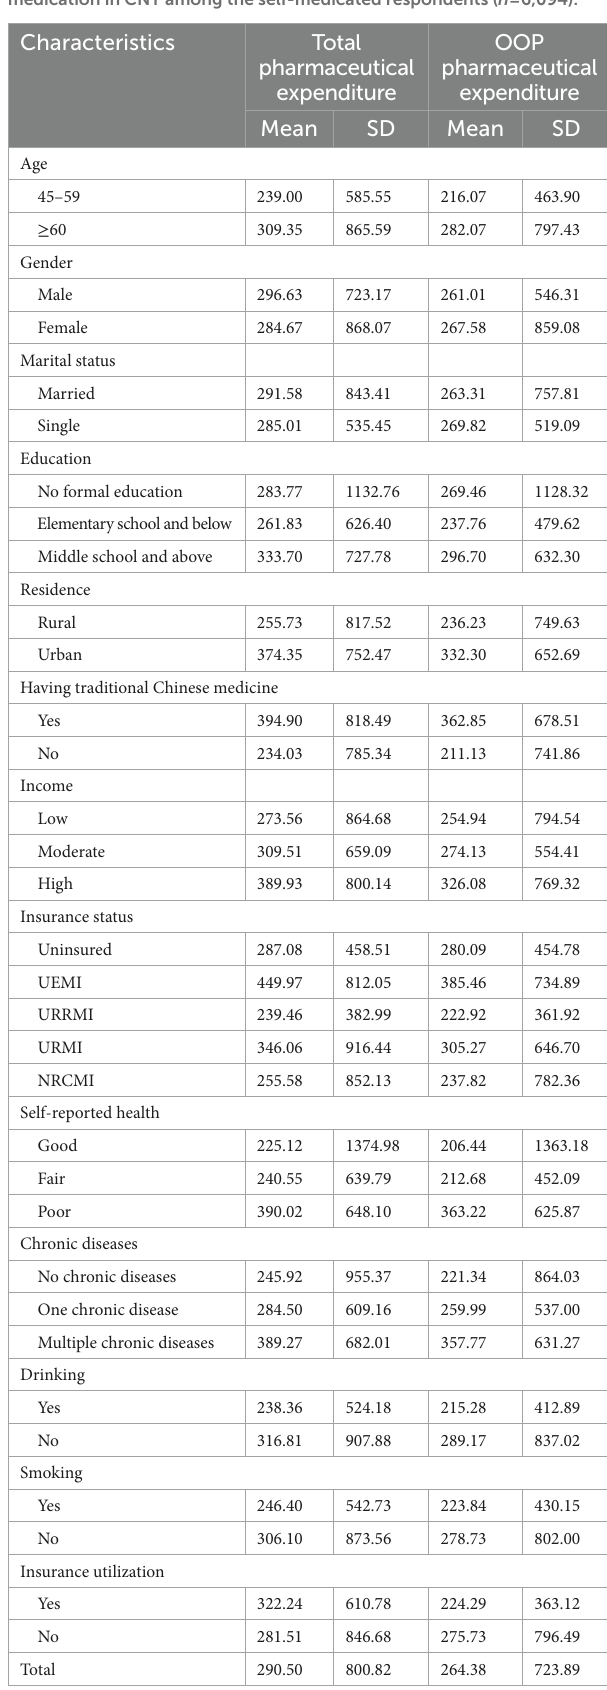
TABLE 3 Total and OOP pharmaceutical expenditure amounts of self- medication in CNY among the self-medicated respondents ( n =